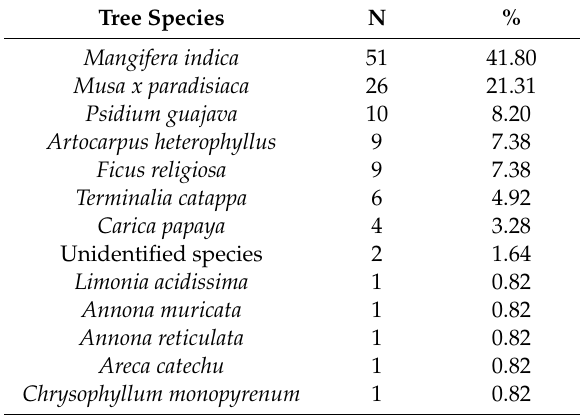
Table 1. Number and percentage of cultivated fruiting trees ( n = 122) located within a 30 m radius of electrocuted flying foxes.